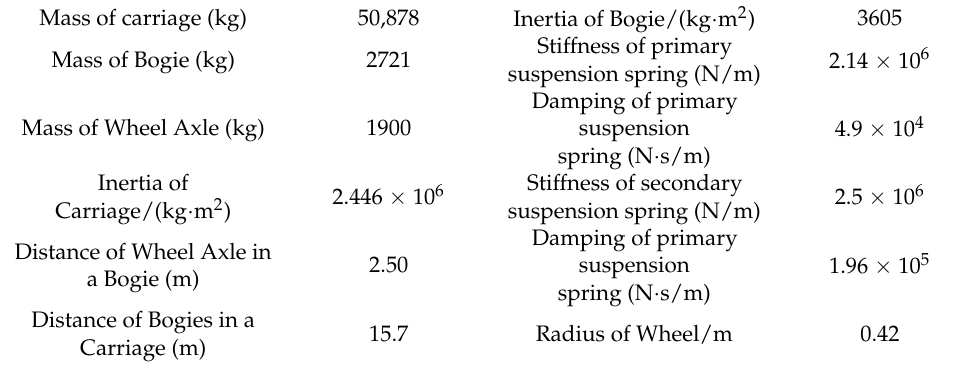
Table 3. Metro-train parameters of type A